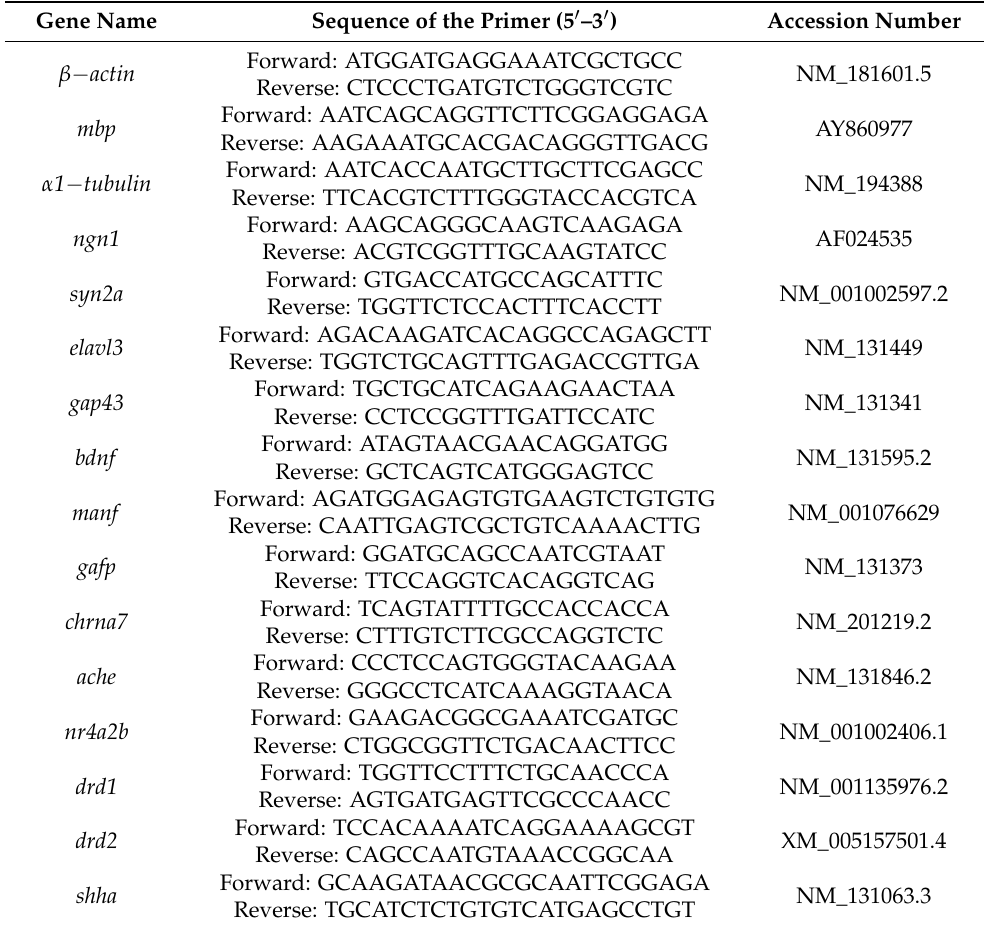
Table 1. Sequences of primers for the genes